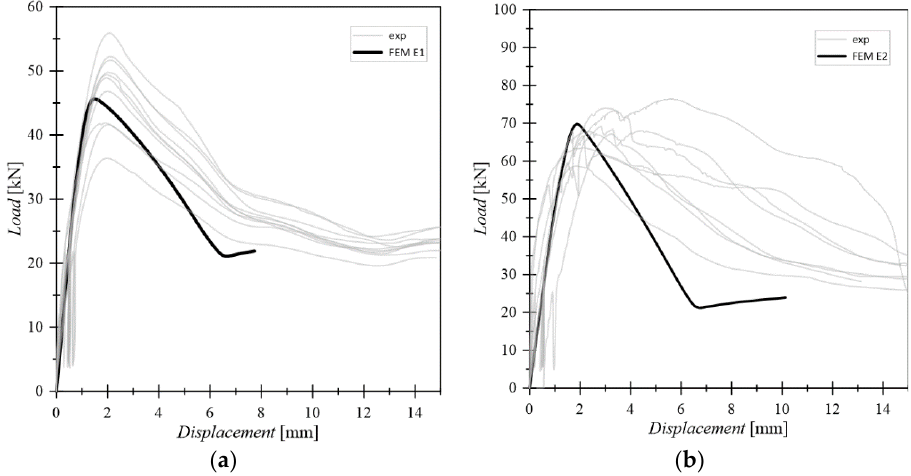
Figure 5. Experimental and FE numerical load-displacement curves for ( a ) clc8160 and ( b ) clc8240 specimens.